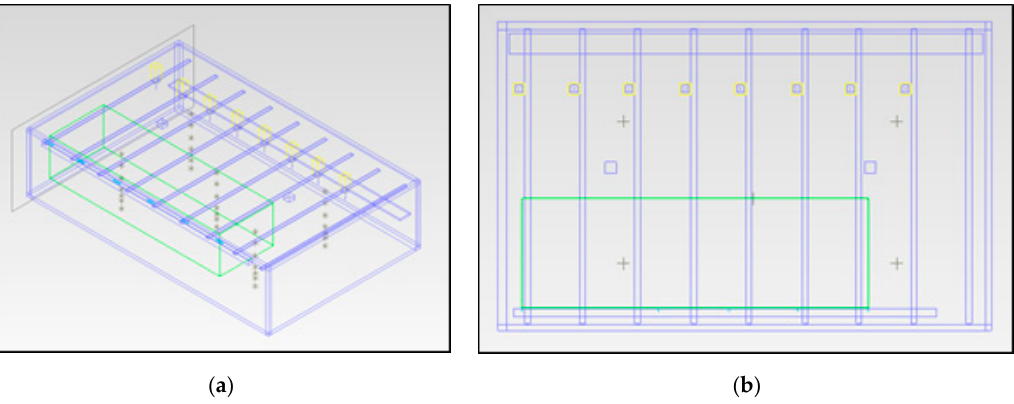
Figure 3. Example of training hall geometry in a computational fluid dynamics (CFD) model (isometric view ( a ) and plan ( b ) of the case with warm air heating and mechanical mixing ventilation). The “+” indicates the location of the monitor points.